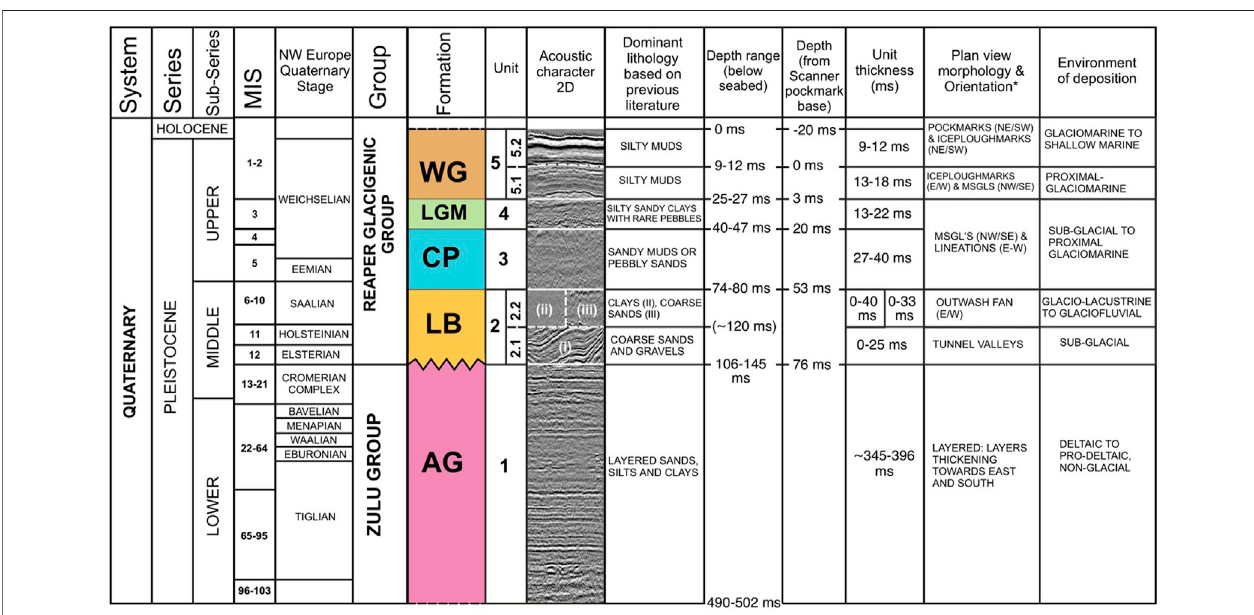
FIGURE3| StratigraphyoftheScannerPockmarkComplex.Thechronostratigraphy,seismostratigraphyandlithostratigraphyoftheScannerPockmarkComplex is described. AG - Aberdeen Ground (purple), LB - Ling Bank (orange), CP - Coal Pit (blue), LGM - Last Glacial Maximum Deposits (green) and WG - Witch Ground (brown). The table has been created from a synthesis of Böttner et al. (2019), Ottesen et al. (2014), Stewart and Lonergan (2011), Stoker et al. (2011), Judd et al. (1994) and Andrews et al. (1990).